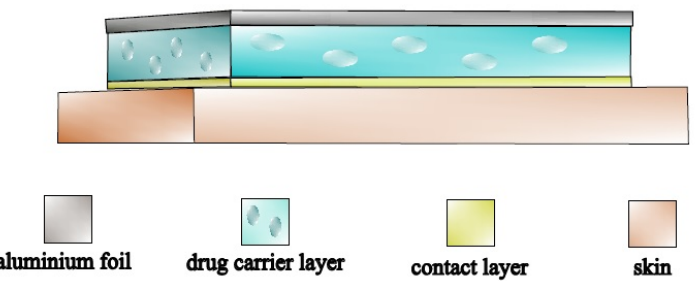
Figure 1. Modified silicone ‐ based polymer matrix ‐ controlled diffusion TTS.